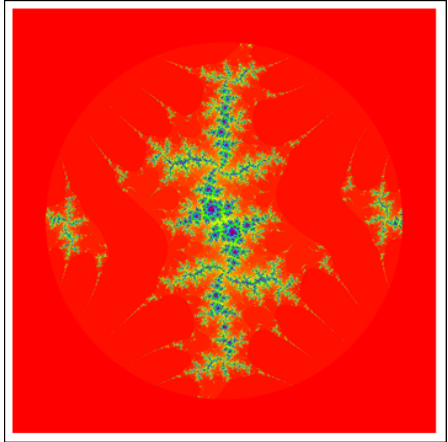
Figure 13. J-set via F-iteration for sin ( z 2 ) + ( 0.3 − 0.7 i ) with image visual time = 83.5 s.